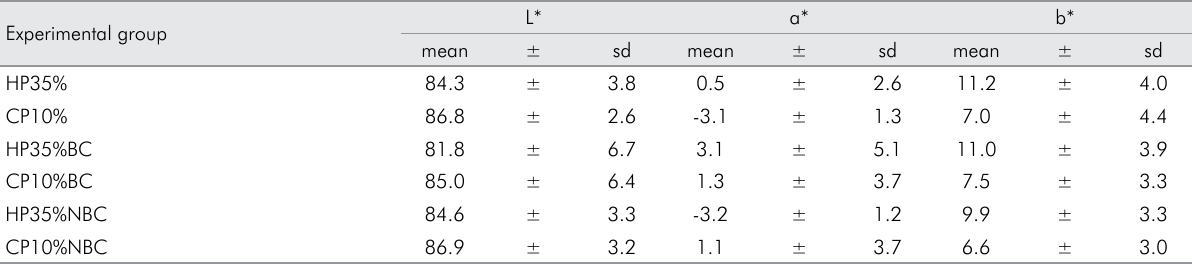
Table 1. Means and standard deviation (±SD) of the baseline color characteristics for each experimental group. Experimental